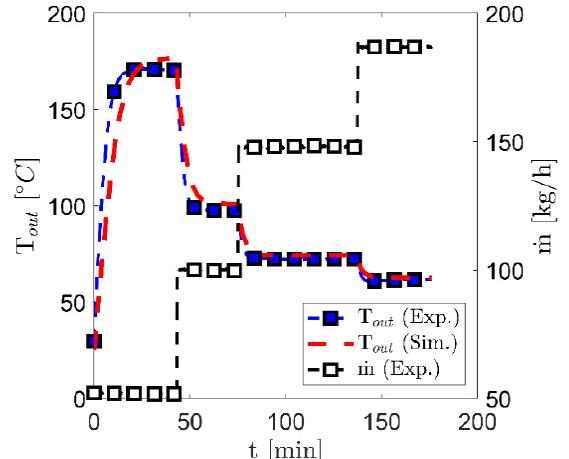
Figure 15. Heating mode—transient outlet temperature (T out ) as a function of the air mass flow rate ( m(cid:4662)